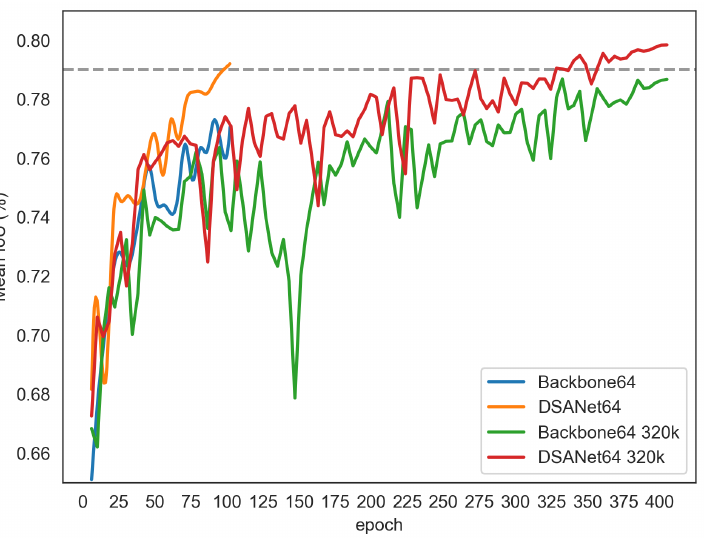
Figure 6. Comparisons between the mean IoU results of the DSANet64 backbone and DSANet64 with 80,000 iterations and 320,000 iterations on the Potsdam